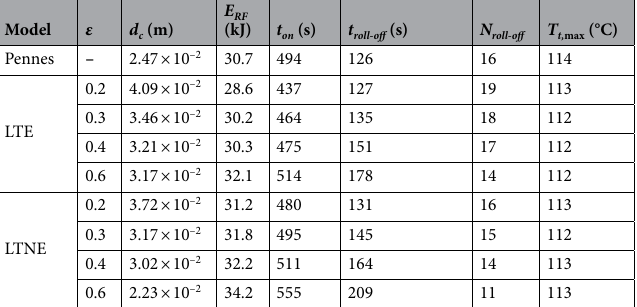
Table 2. Results for different bioheat models at 65 V. d c : coagulation diameter; E RF : applied RF energy; t on : total time generator is “on”; t roll-off : time at first roll-off; N roll-off : number of roll-offs.